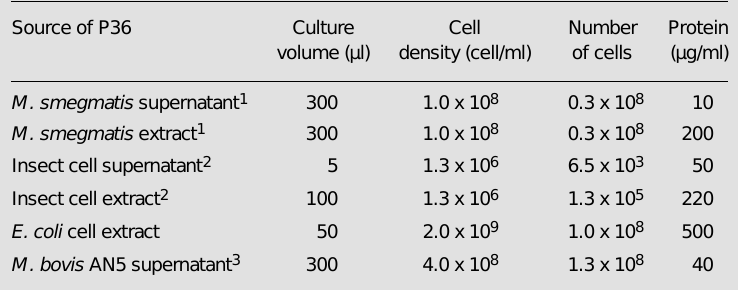
Table 2 - Amount of cells that produce detectable P36 in Western